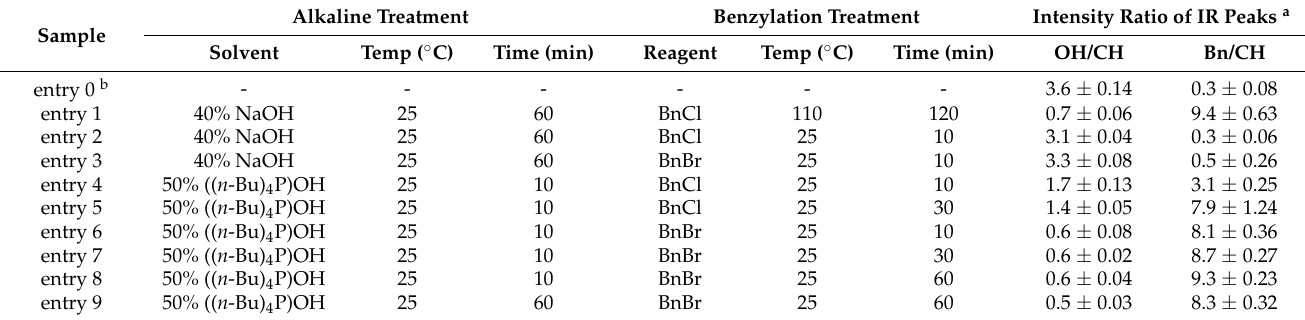
Table 1. Treatment conditions of benzylation and the intensity ratio of the ATR-IR